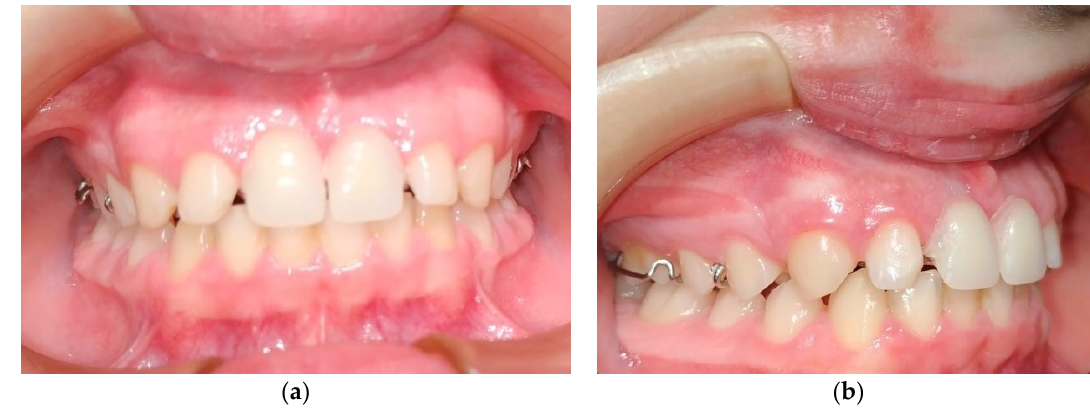
Figure 3. ( a ) Intra-oral view of the Hawley appliance with two central incisors; ( b ) Lateral right view of the occlusion of the trumpet player and the appliance.